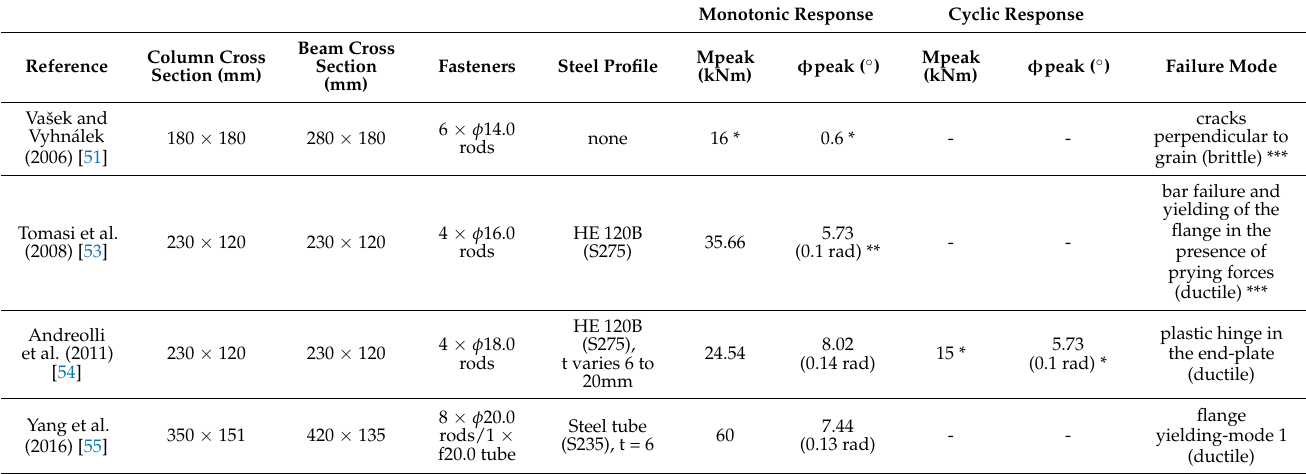
Table 6. Comparison of the collected experimental results for glued-in rods